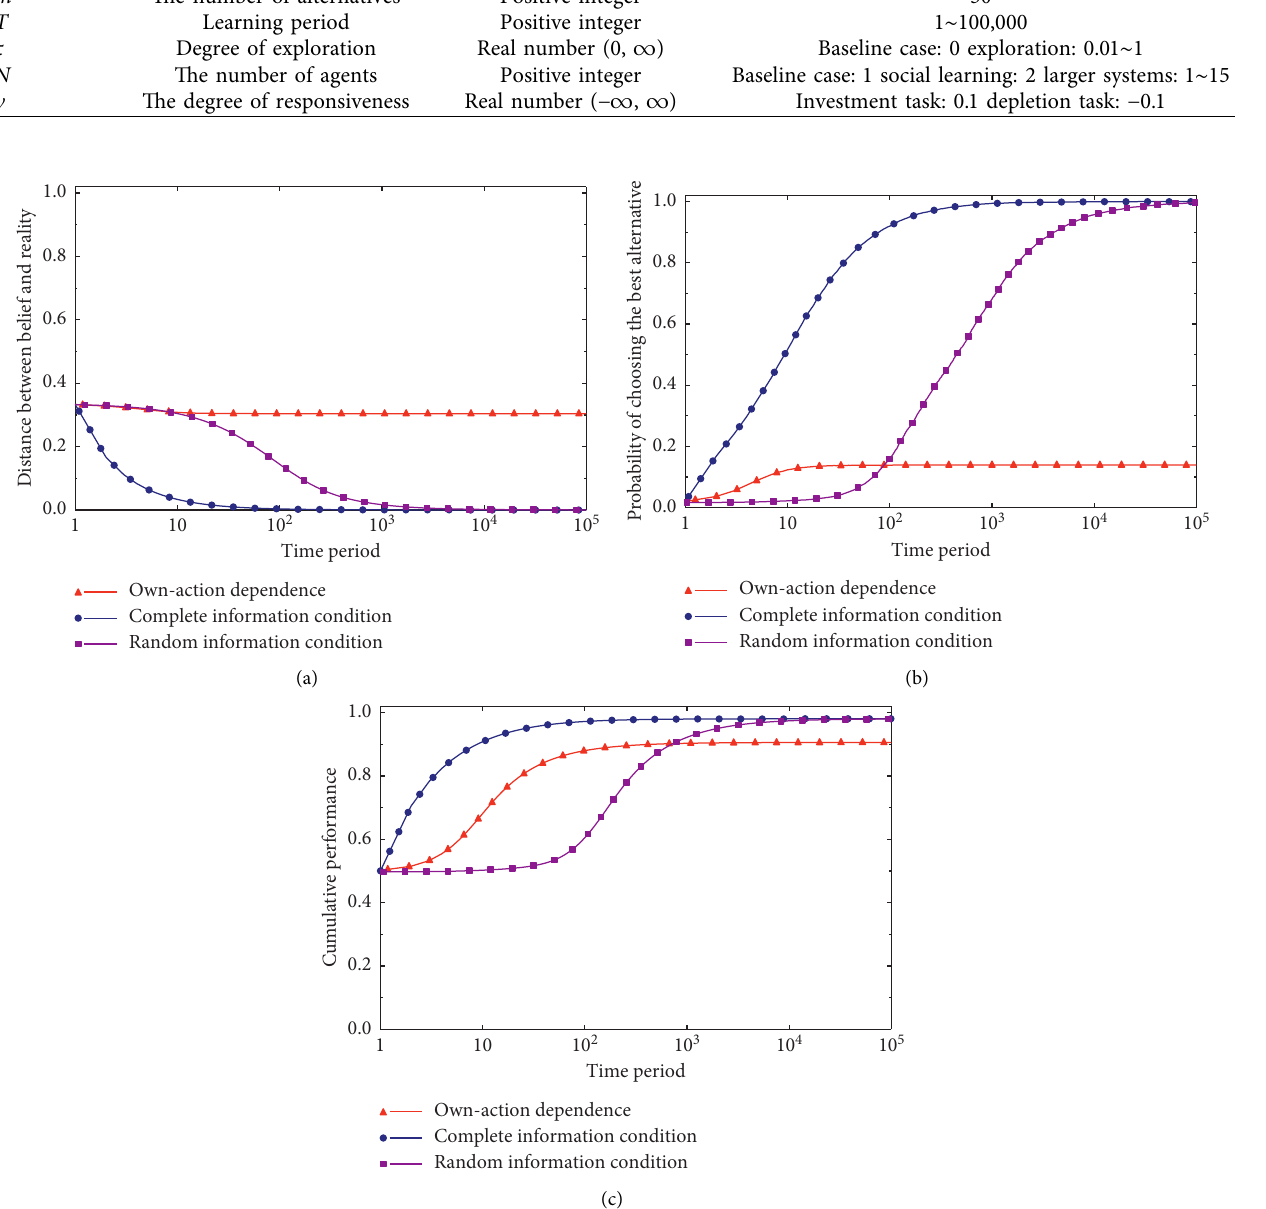
Figure 1: Self-confirming biased beliefs for different information conditions. (a) Degree of biased beliefs (i.e., the distance between belief and reality), (b) probability of choosing the best alternative, and (c) cumulative performance (divided by time